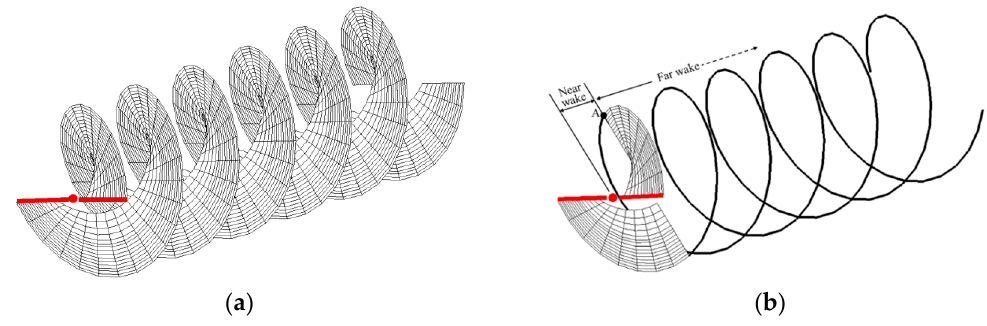
Figure 1. Schematic of the initial wakes of different FVW models. ( a ) FVSW model. ( b ) TVW model.